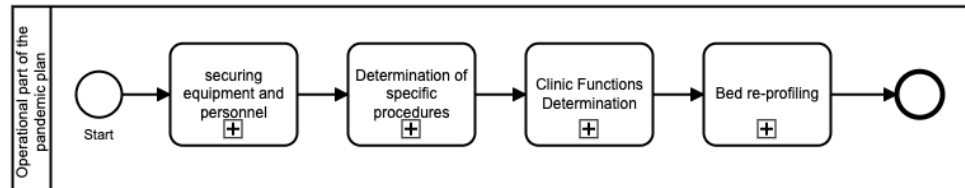
Figure 7. Operational part.